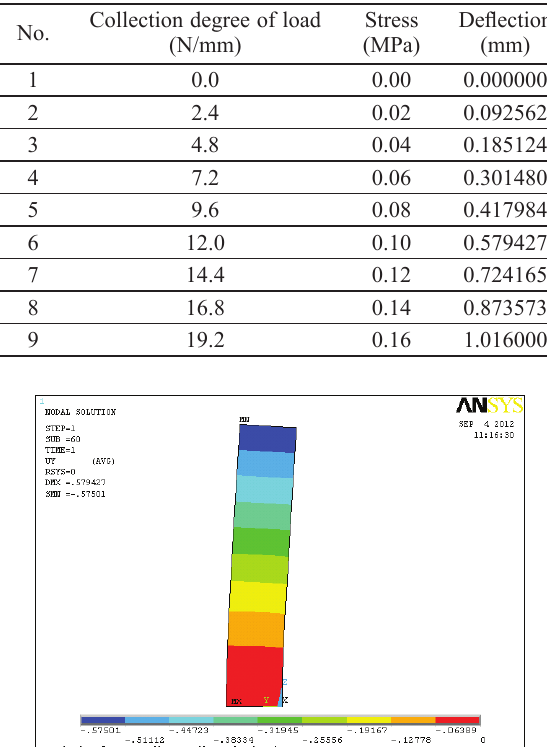
Table 2. Pile head deflection obtained by numerical simulation under different loads